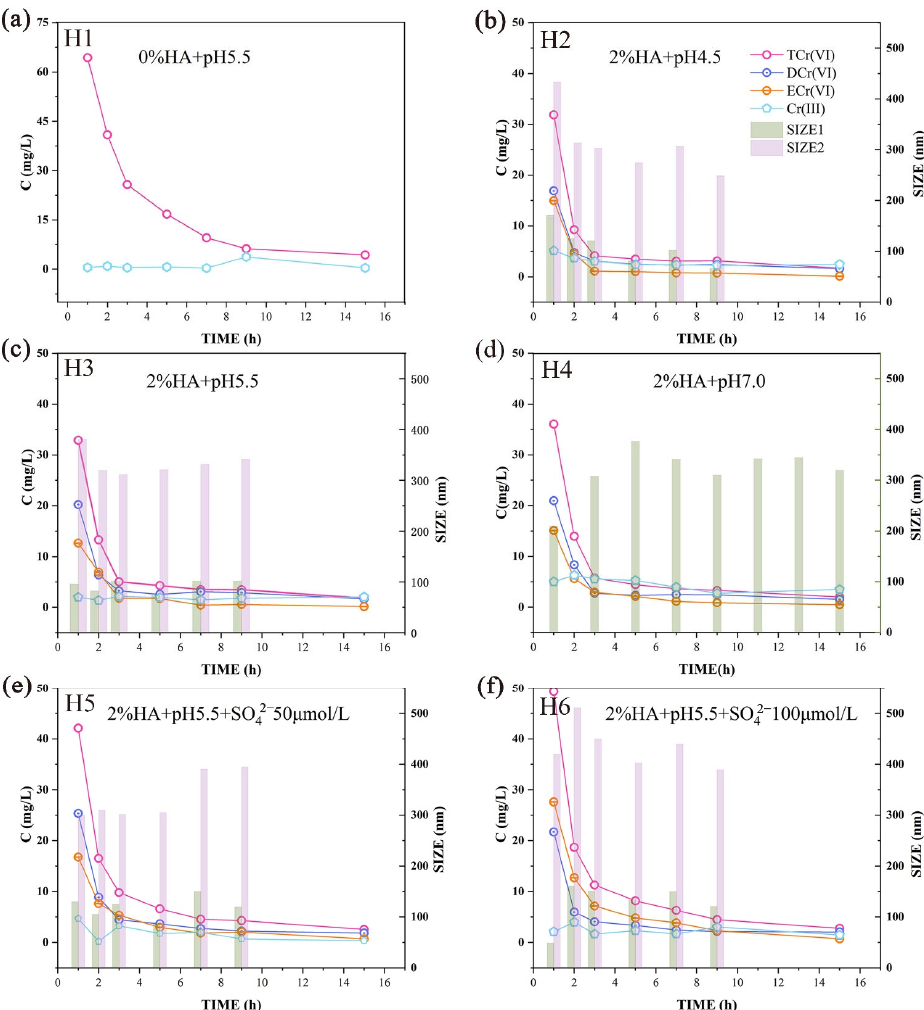
Figure 3. Concentrations of total Cr (VI) (TCr (VI)), dissolved Cr (VI) (DCr (VI)), colloidal Cr (VI) (ECr (VI)), and Cr (III) and the change in HA–Cr system colloid particle size (SIZE1 (the first peak detected by the instrument), SIZE2 (the second peak detected by the instrument) (if available)) during the leaching process. ( a – d ) H1–H4 represent concentration of Cr and the particle size of the HA–Cr system at different pH during the leaching process. ( e , f ) H5–H6 represents concentration of Cr and the particle size of the HA–Cr system at different sulfate concentrations during the leaching process.